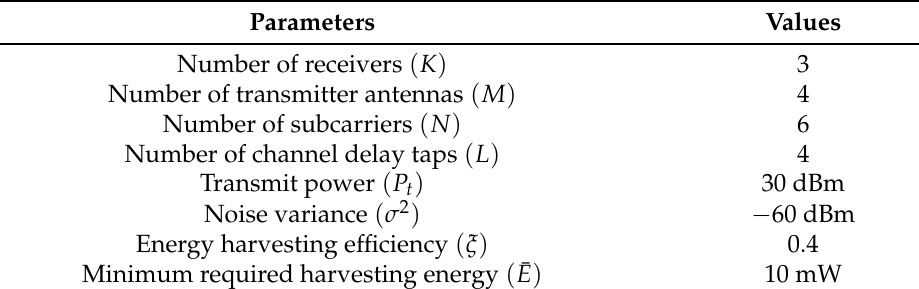
Table 1. Computer simulation parameters.